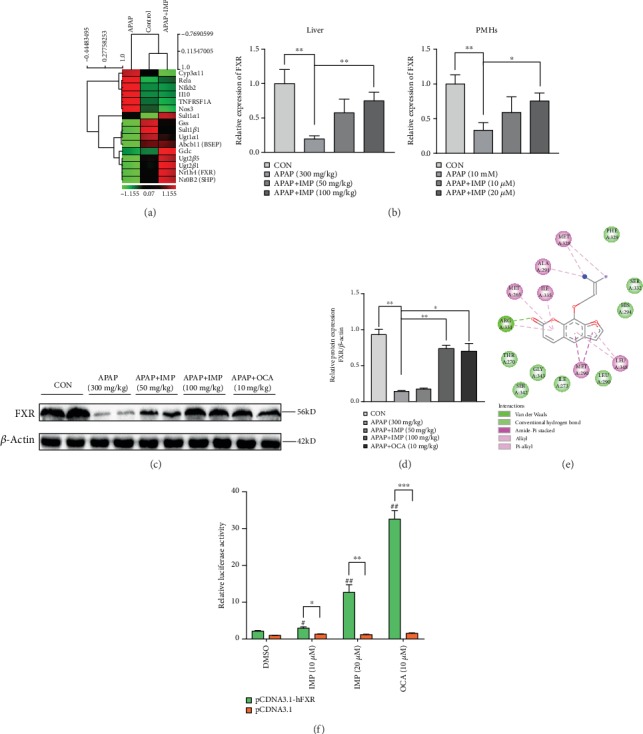
Results of transcriptome in vivo analysis (tiVA) and in vitro experimental verification of activation of FXR signaling with IMP. (a) Heatmap representation of the transcriptome analysis of 19 differentially expressed genes (IMP pretreatment mediated a reversal of inhibition of antioxidant gene expression and FXR-targeted genes induced by APAP overdose). (b) Pretreatment of IMP improves the impaired mRNA expression of FXR and FXR-dependent downstream target genes in liver tissue and PMHs. The mRNA levels of FXR were determined by qRT-PCR. (c) Pretreatment of IMP reverses the downregulation of the protein levels of FXR in liver tissue induced by APAP. (d) Quantitative analysis of scanning densitometry of protein bands for FXR in liver tissue. (e) The 2D structure with the predicted binding details of IMP to hFXR ligand-binding domain (LBD) (rendered in colored sticks). (f) A standard dual-luciferase assay was carried out on HEK293T cell lysates, transiently transfected with pCDNA3.1-vector, pCDNA3.1-hFXR, and pGL3-basic-hBSEP (200 ng per well), and pGL3-CMV Renilla luciferase control reporter vectors were used as the transfection control. Relative luciferase activity was determined by the ratio of firefly luciferase/Renilla luciferase activity (n = 3). ∗p < 0.05; ∗p < 0.01; ∗∗∗p < 0.001, compared to the same treatment group transfected with empty vector or with vehicle-treated control group, and ##p < 0.01 versus the DMSO control group transfected with the receptor expression plasmid. FXR: Farnesoid X receptor; mRNA: messenger RNA; PMHs: primary mouse hepatocytes; qRT-PCR: quantitative real-time PCR; BSEP: bile salt export pump.